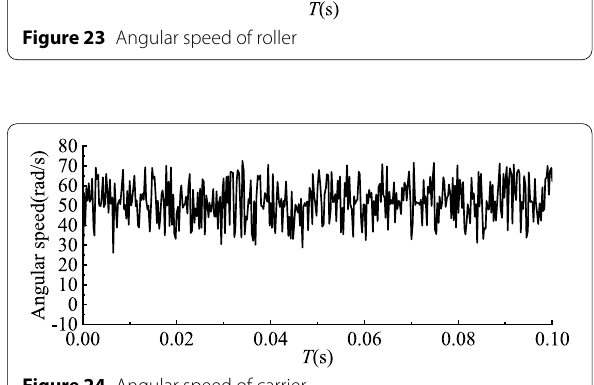
Figure 24 Angular speed of